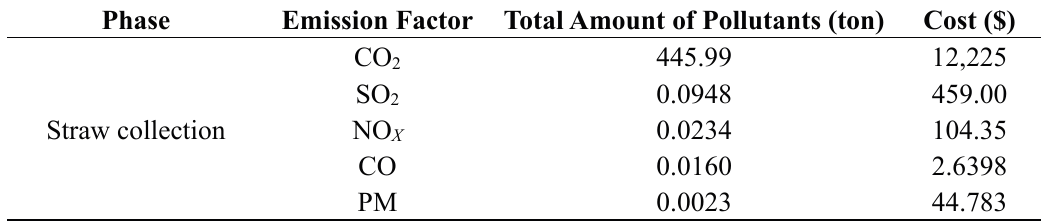
Table 9. External costs of a 30 MW biomass power